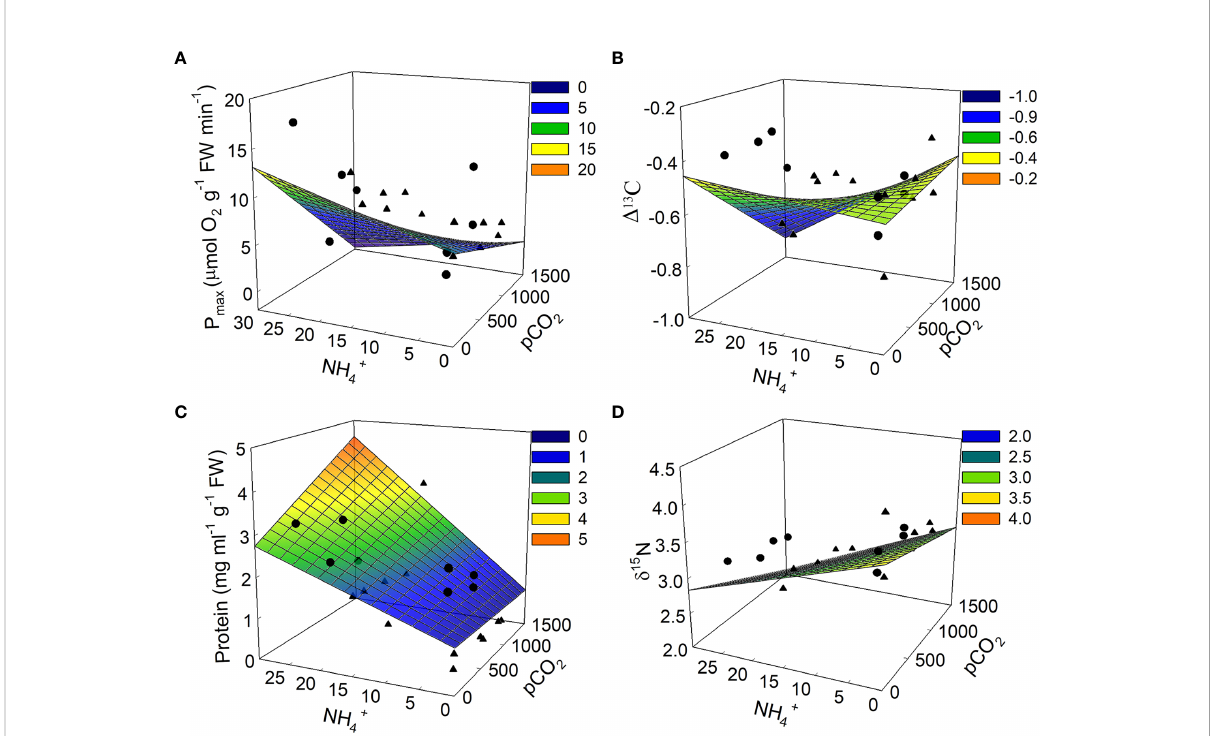
FIGURE 4 Modeled physiological responses for Ulva lactuca based on responses to pCO 2 and NH 4+ treatments in laboratory experiments. (A) P max (B) D 13 C (C) Soluble protein concentrations and (D) d 15 N. The linear expression y= b was used to fi t model surface with conventional regression coef fi cients using weighted model-averaging (see Table 2). Overlaying the modeled mesh plots are the date from each trial where trial 1 is represented by circles and trial 2 is represented by triangles.